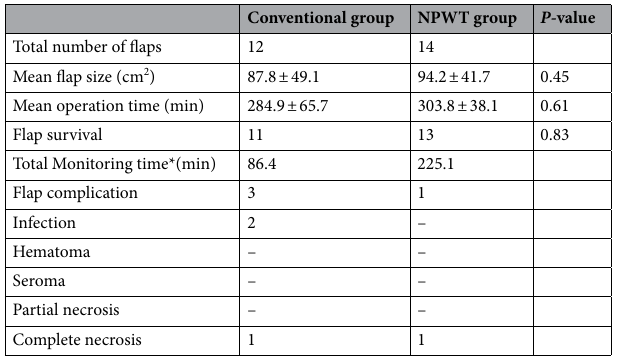
Table 2. Surgical outcomes of conventional monitoring and NPWT monitoring groups. NPWT: negative pressure wound therapy. *Total monitoring time: up to postoperative day 5.